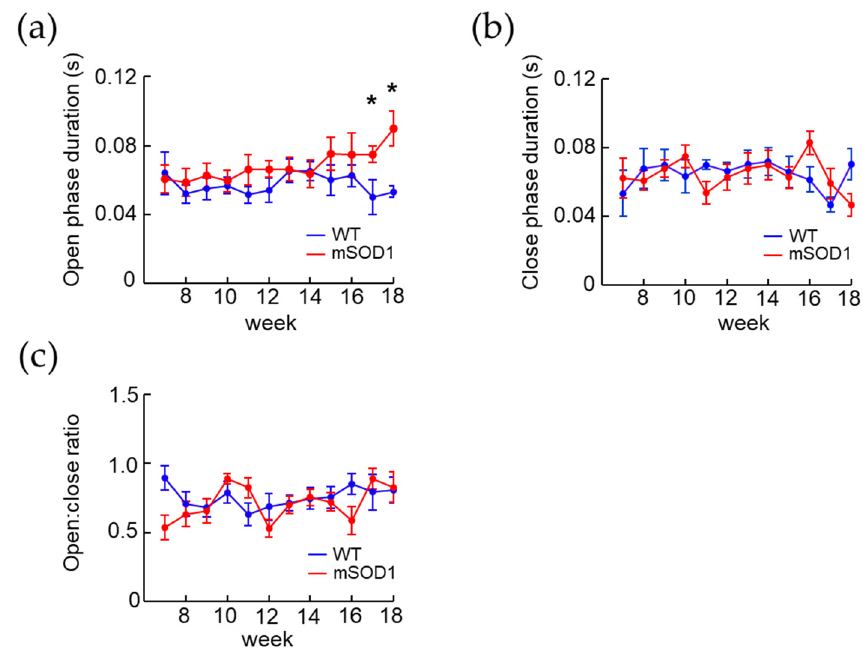
Figure 3. Changes over time in the opening and closing mouth characteristics in a mouse model of ALS. Open phase duration, close phase duration, and open:close ratio detected using an AI model. WT (mala, n = 10) and mSOD1 (male, n = 9) results from 7–18 weeks of age. ( a ) In mSOD1, open phase duration was prolonged after 12 weeks of age and significantly prolonged after 15 weeks old. ( b , c ) No significant difference was found for either close phase duration or open:close ratio. * p <